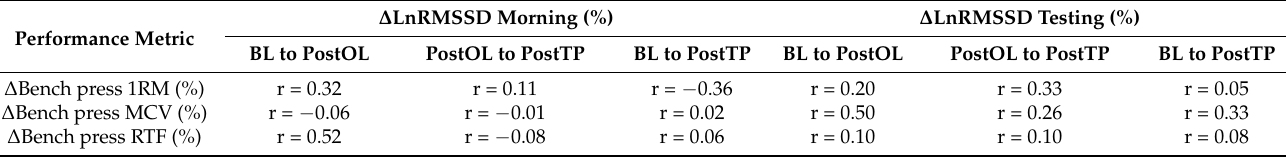
Table 3. Correlation coefficients for changes ( ∆ ) in LnRMSSD and bench press performance across microcycles. Performance